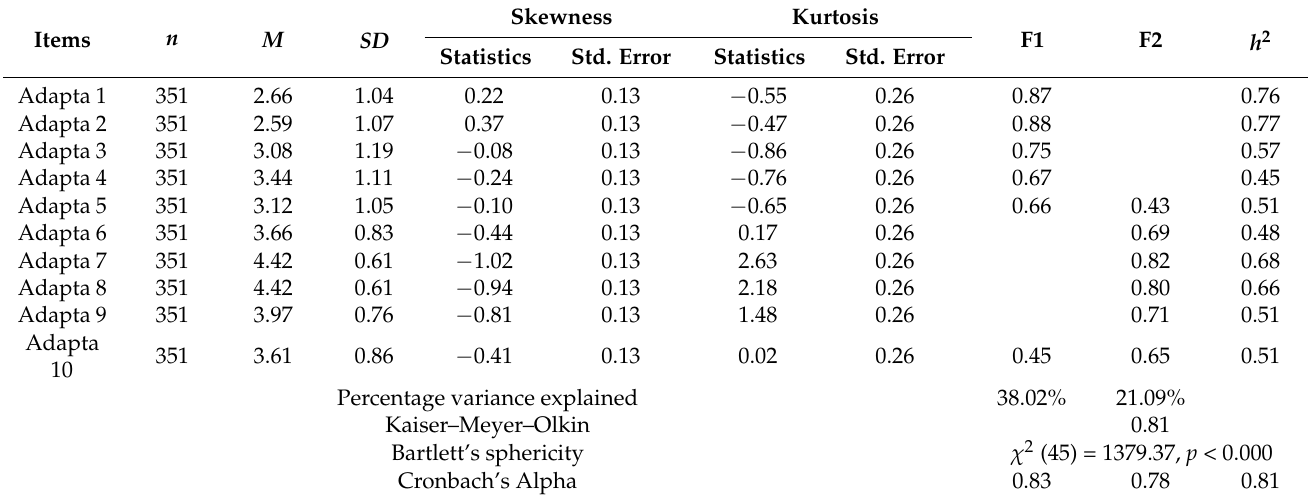
Table 1. Descriptive statistics. Factor structure, communalities ( h 2 ) eigenvalues, Cronbach’s alpha and percentage variance explained. Extraction method: Principal components factoring (Varimax rotation).